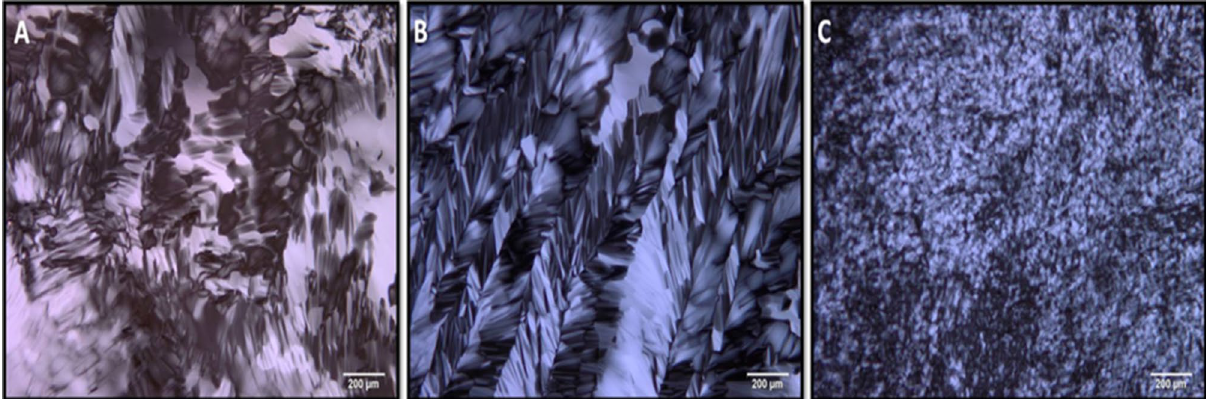
Figure 1. Polarizing optical microscopic images recorded for ( A ) Triton X-100 and aqueous solution consisting of 1 mM [Fe(CN) 6 ] 3−/4− , ( B ) Triton X-100 and [Fe(CN) 6 ] 3−/4− along with artificial sweat solution and ( C ) Triton X-100 and [Fe(CN) 6 ] 3−/4− along with saliva solution at a temperature of 25 °C respectively. These images clearly show the formation of hexagonal liquid crystalline phase for all these